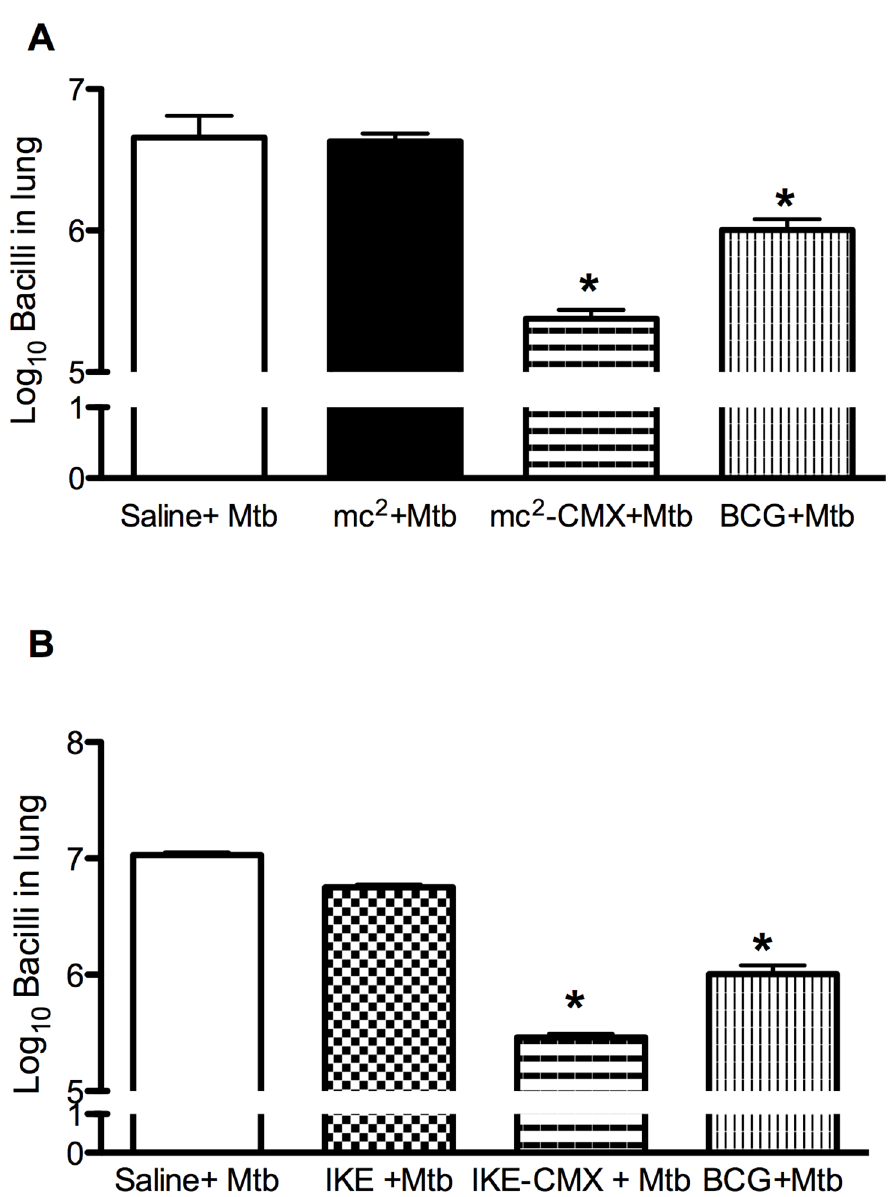
Figure 8. Bacterial load in the lungs of BALB/c mice 45 days after Mycobacteriumtuberculosis challenge. Ninety days after immunization, three mice from each group (control, BCG and rBCG-CMX) were challenged with 10 5 CFU of Mycobacterium tuberculosis H37Rv intravenously into the orbital sinus plexus. One additional group of animals received a booster of rCMX/CPG DNA, 30 days after rBCG-CMX vaccination and challenged with Mtb 30 days post the immunization (rBCG-CMX + CMX). Forty-five days after challenge, mice were euthanized and the anterior and mediastinal right lung lobes were collected, homogenized, and plated on Middlebrook 7H11agar supplemented with OADC to determine the bacterial load by counting the number of CFU. * Significant differences between infected (control) and vaccinated groups. # Significant differences between rBCG- CMX and rBCG-CMX + CMX groups. | Significant differences between rBCG-CMX and BCG groups analyzed by t test (p , 0.05).